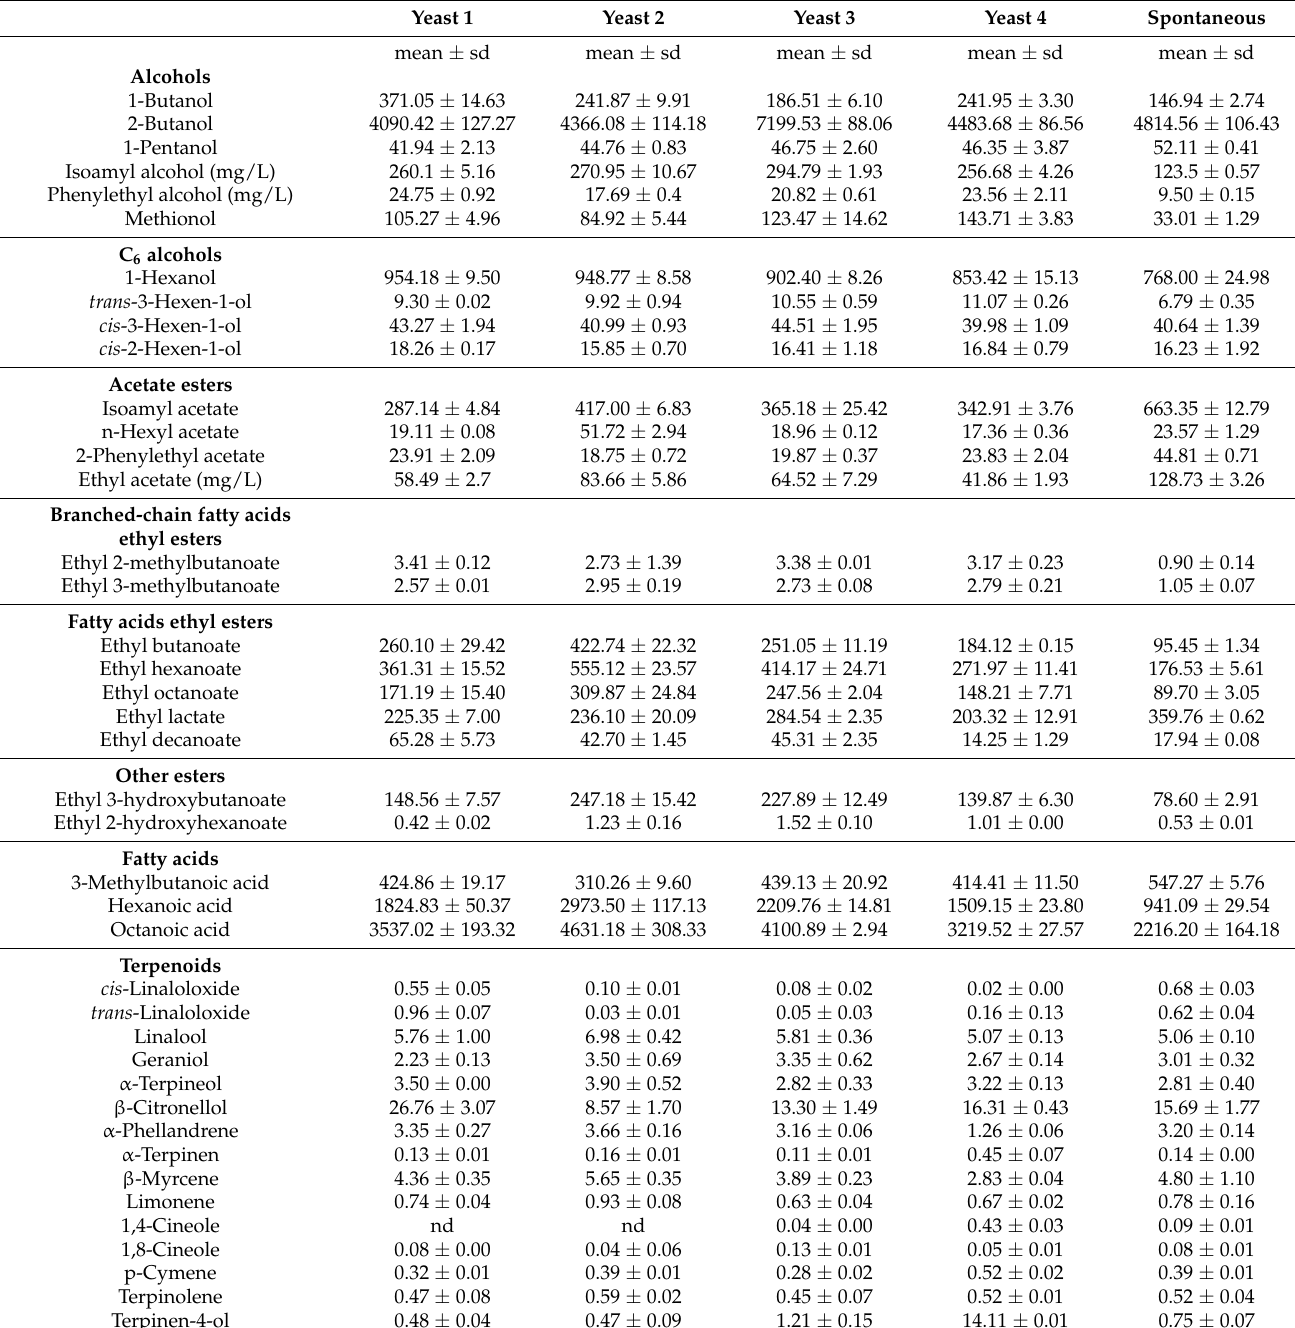
Table 3. Concentration ( µ g/L) of volatile compounds of Area 1 Corvina